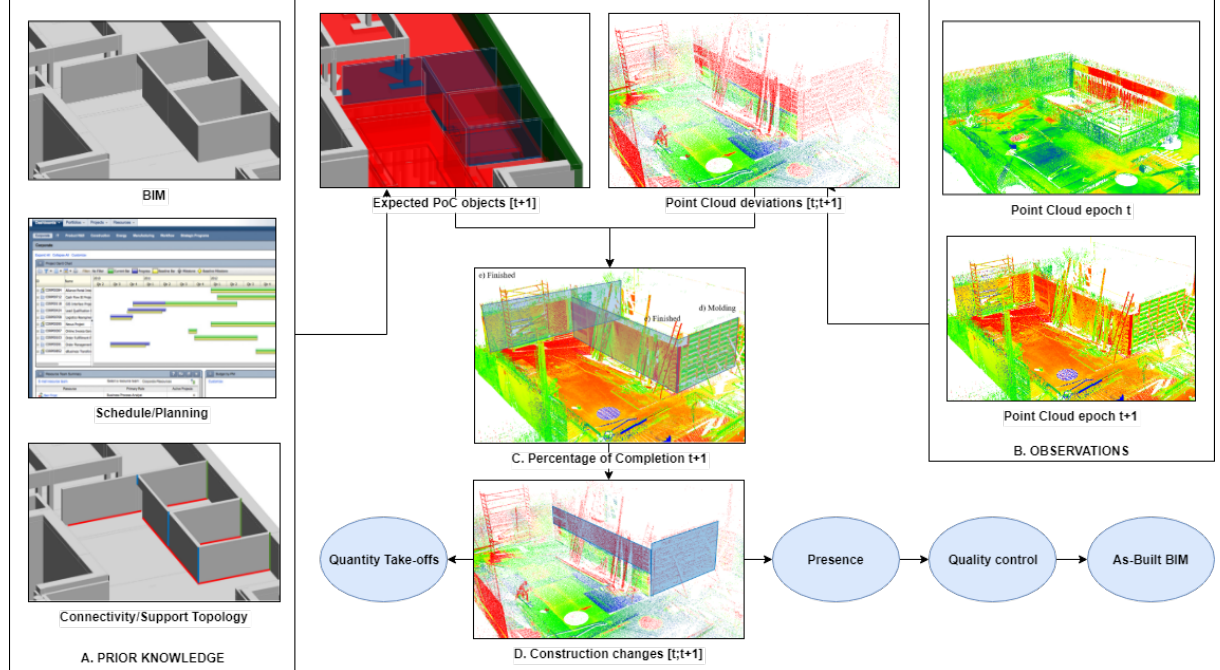
Figure 3: Overview of the workflow to compute the Percentage of Completion (PoC) of in-situ cast concrete walls: (A) the retrieval of the expected PoC objects from 4D BIM including geometry and planning information, (B) the observed geometry from point cloud data and (C-D) the estimation of the PoC from the subsequent